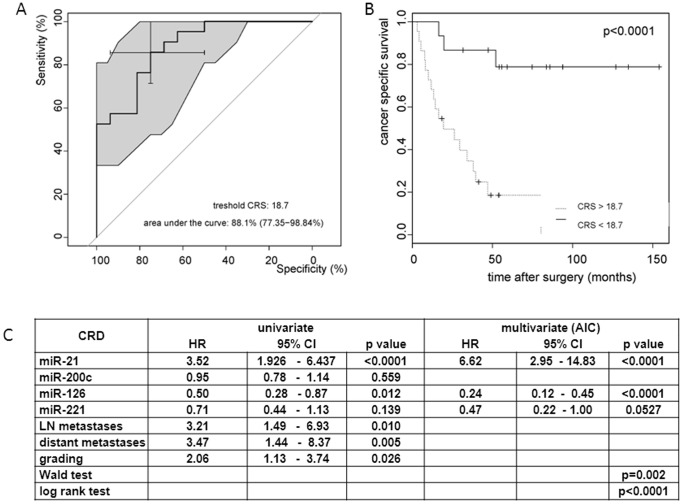
Kaplan Meier survival analysis and receiver operating characteristics (ROC) curve for CSS in ccRCC/TT patients (n = 37) stratified by the CRS for miR-21, miR-126 and miR-221.CRS were calculated as described in the material and methods part. A) ROC curve; the cross indicates the calculated cutoff score for the CRS resulting in the highest sensitivity and specificity The selected cut off score is indicated in graph B) The ccRCC/TT study cohort (n = 37) was stratified by the calculated risk score using Kaplan Meier analysis. Kaplan Meier curves with log rank test and risk stratification by CRS are shown. C) Uni- and multivariate Cox regression analysis for cancer related death in the ccRCC/TT collective determined by relative goodness of fit with AIC including selected miRs and clinico-pathological factors as variable.